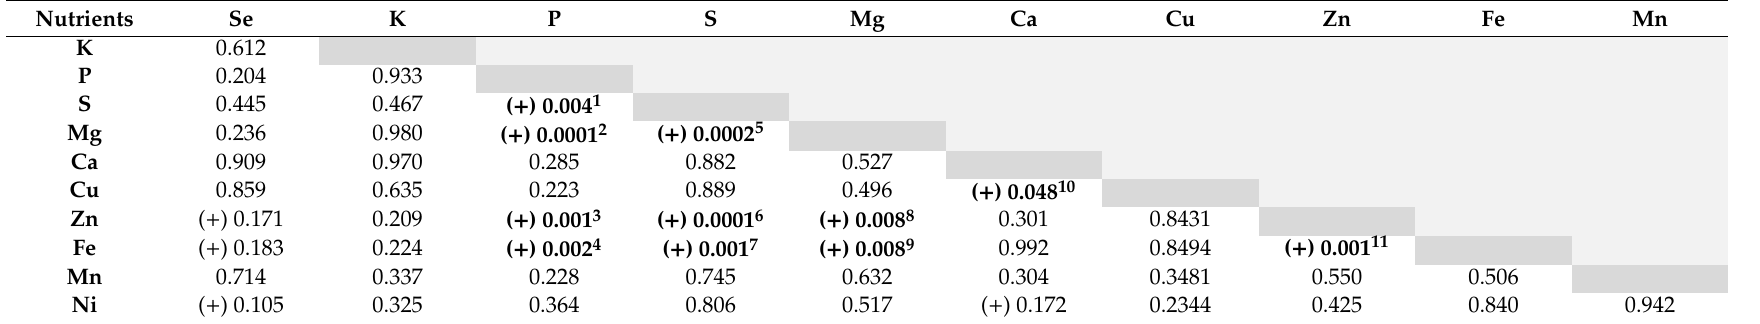
Table 5. p -values for positive ( + ) and negative ( − ) correlations between nutrient concentrations in Brazil nut batch B ( n =